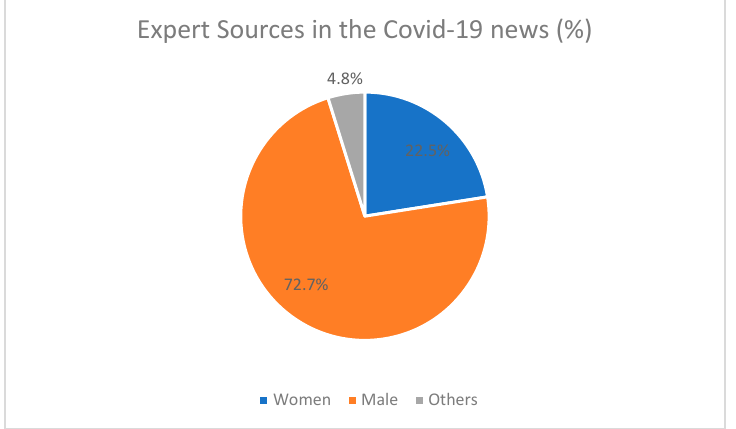
Figure 1. Percentages of expert sources in the analyzed COVID-19 news by gender.